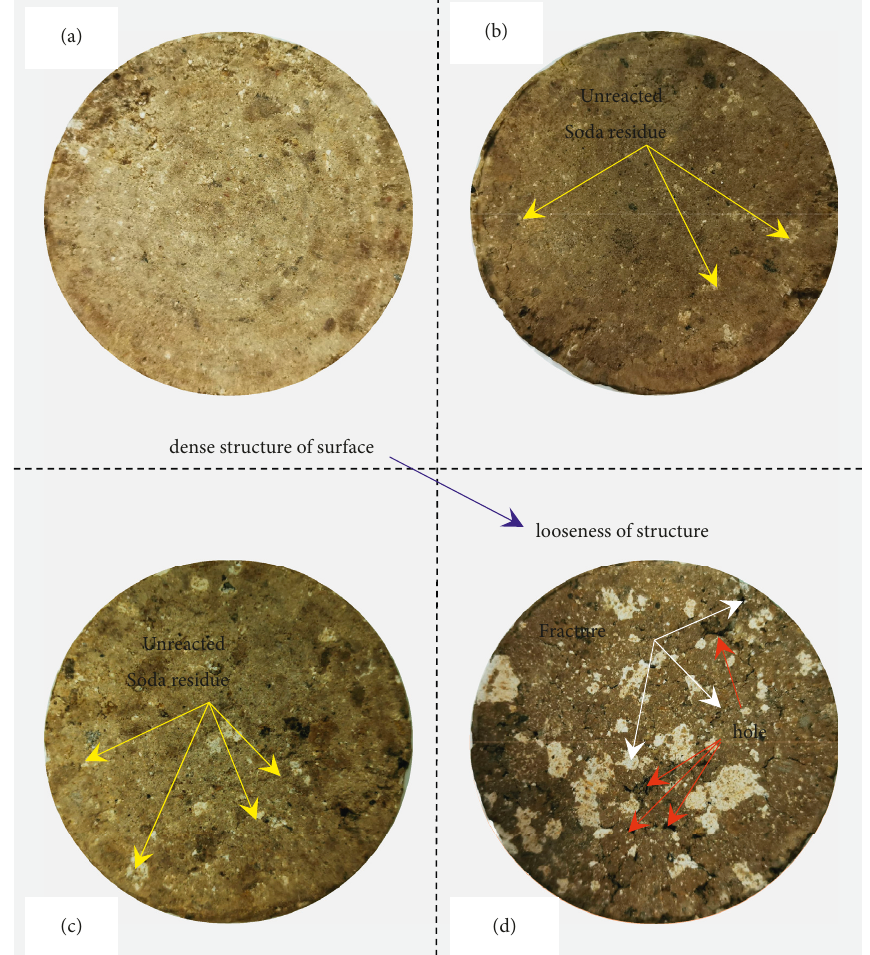
Figure 11: Actual image of SRLS